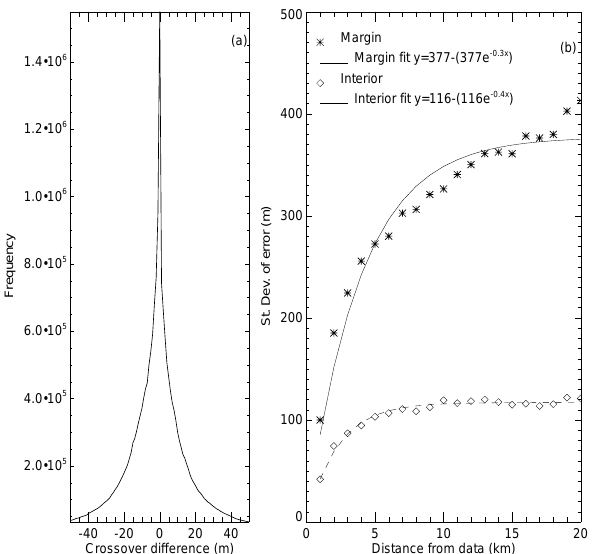
-40 -20 0 20 40 Crossover difference Fig. 6. (a) Histogram of inter-track, intra-instrument differences for all airborne data points within 50m of each other. (b) Standard de- viation of difference between bed elevations created using all data and using a sub-set of the data in “marginal” areas with a roughness standard deviation greater than 170m (asterisks) and the “interior” region where the roughness was below this threshold (diamonds) (see Fig. S3 in the Supplement). An exponential fit to the data is shown as solid (“margins”) and dashed (“interior”) lines.